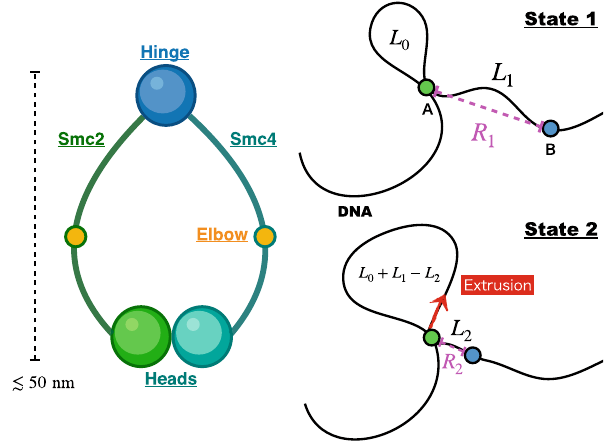
Fig. 1 Model description. Left panel: Caricature of the structure of condensin, which has two heads (ATPase domains) and a hinge connected by coiled-coils, labeled Smc2 and Smc4. In the middle of the CCs, there is a fl exible kink, referred to as an elbow. Right panel: A schematic of the physical picture for one-sided loop extrusion based on the architecture of a generic SMC complex. DNA is attached to two structural regions on condensin. In state 1 (upper panel) the conformation of condensin is extended with the spatial distance between A and B equal to R 1 . The genomic length at the start is L 0 , which can be large or small. After the conformational transition (state 1 to state 2) the distance between A and B shrinks to R 2 , and the length of the extrusion during the single transition is Δ L =